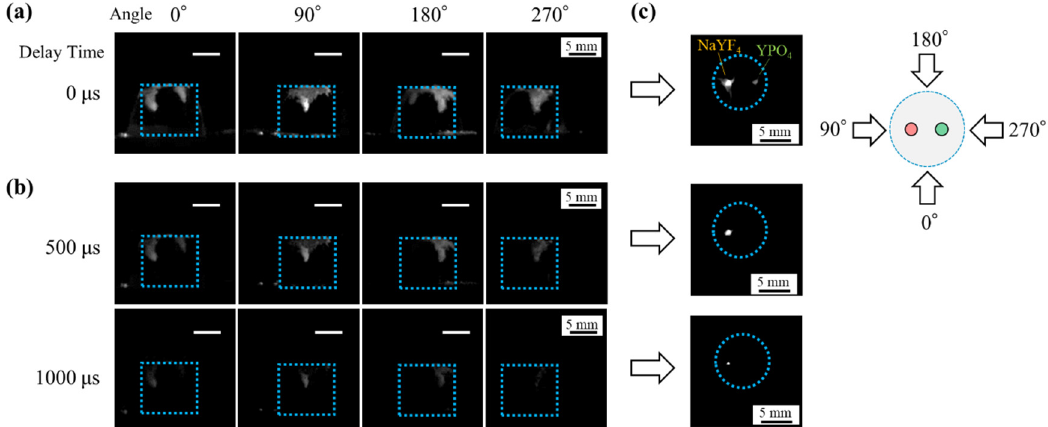
Figure 3. Two-dimensional projected images and reconstructed cross-sectional images of NIR fluorophores recorded by the NIRF-TGI-CT image acquisition system. ( a ) Two-dimensional projected images acquired from each angle at a delay time of 0 μ s after turning off the laser for excitation. ( b ) Projected images of the fluorescence decay recorded at an indicated delay time from each angle. Integration: 100 μ s. Laser power: 5 W/cm 2 . ( c ) Reconstructed cross-sectional images of NIR fluorophores of the sample at each delay time. The dotted blue lines indicate the form of the cylinder- shaped agar gel, which looks rectangular when seen from the side to collect the projected images ( b ), and circular when seen at cross-sections, as shown in ( c ). The red and green in the illustration indicate NaYF 4 and YPO 4 co-doped with Nd 3+ and Yb 3+ .